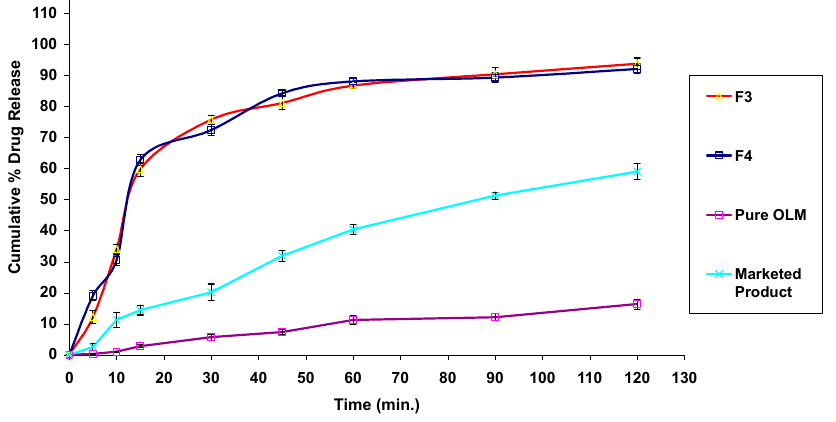
Figure 10. In vitro release profiles of OLM S-SNEDDS formulae (F3 and F4) compared with pure OLM and marketed product.